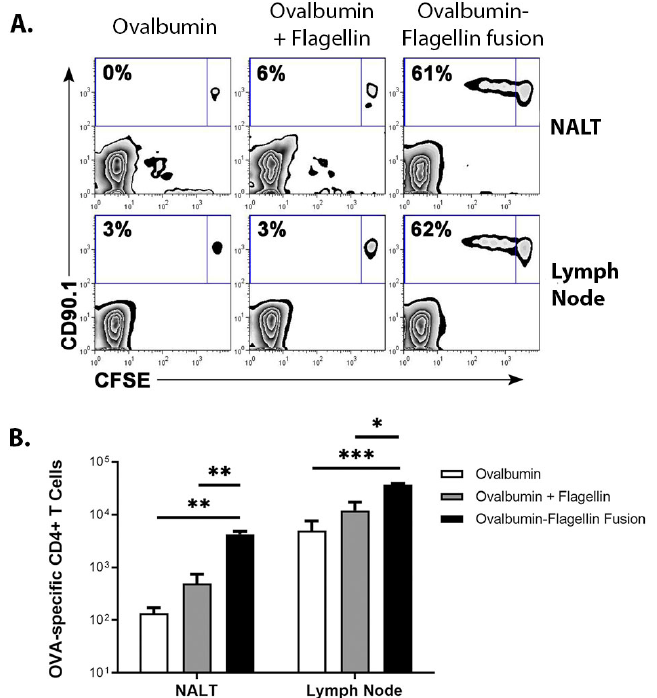
Figure 3. Proliferation of OVA ‐ specific CD4 + T cells in the NALT following immunization with flagellin ‐ OVA fusion protein. NALT were harvested three days following i.n. immunization with ovalbumin, flagellin plus ovalbumin, or flagellin ‐ ovalbumin fusion protein. ( A ) CFSE dilution by OVA ‐ specific CD4 + T cells was measured by flow cytometry. Plots are gated on CD4 + lymphocytes. Numbers convey the percentage of OVA ‐ specific cells in each condition that underwent at least one division prior to harvest ( B ) Intranasal instillation of flagellin ‐ ovalbumin stimulated significantly higher levels of antigen ‐ specific cell population expansion in the NALT ( p < 0.003) and LN ( p < 0.001) relative to mice immunized with ovalbumin. The absolute numbers of OVA ‐ specific CD4 + T cells recovered from the NALT (** p = 0.003) and LN (*** p < 0.001) of mice immunized with flagel ‐ lin ‐ ovalbumin was significantly higher than the number of cells recovered from mice immunized with ovalbumin or ovalbumin plus flagellin as separate proteins ( p < 0.01 for NALT and p < 0.05 for LN). An average of 140 and 5100 CD90.1 + cells were recovered from the NALT and LN, respec ‐